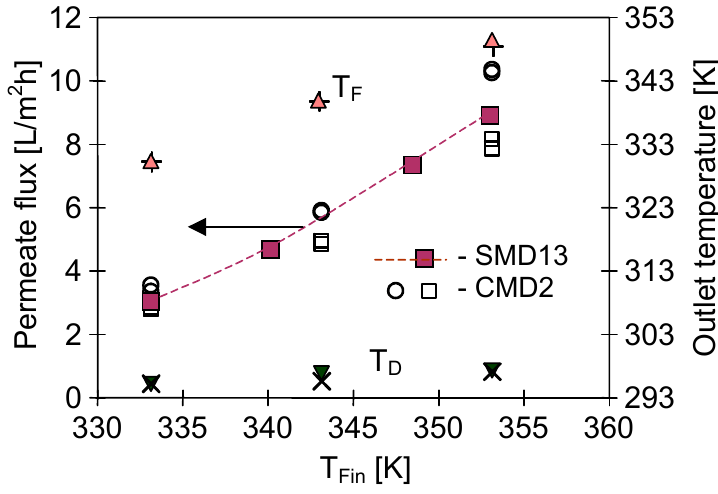
Figure 18. The influence of feed temperature on the permeate flux and feed/distillate outlet temperature. Capillary module CMD2. T Din = 290 K, v F = 0.6 m/s, v D = 0.3 m/s. □ ▲▼ —feed on the housing side; ○+x —feed inside the capillary. ■ —flux obtained for SMD13 module (Mode 1).